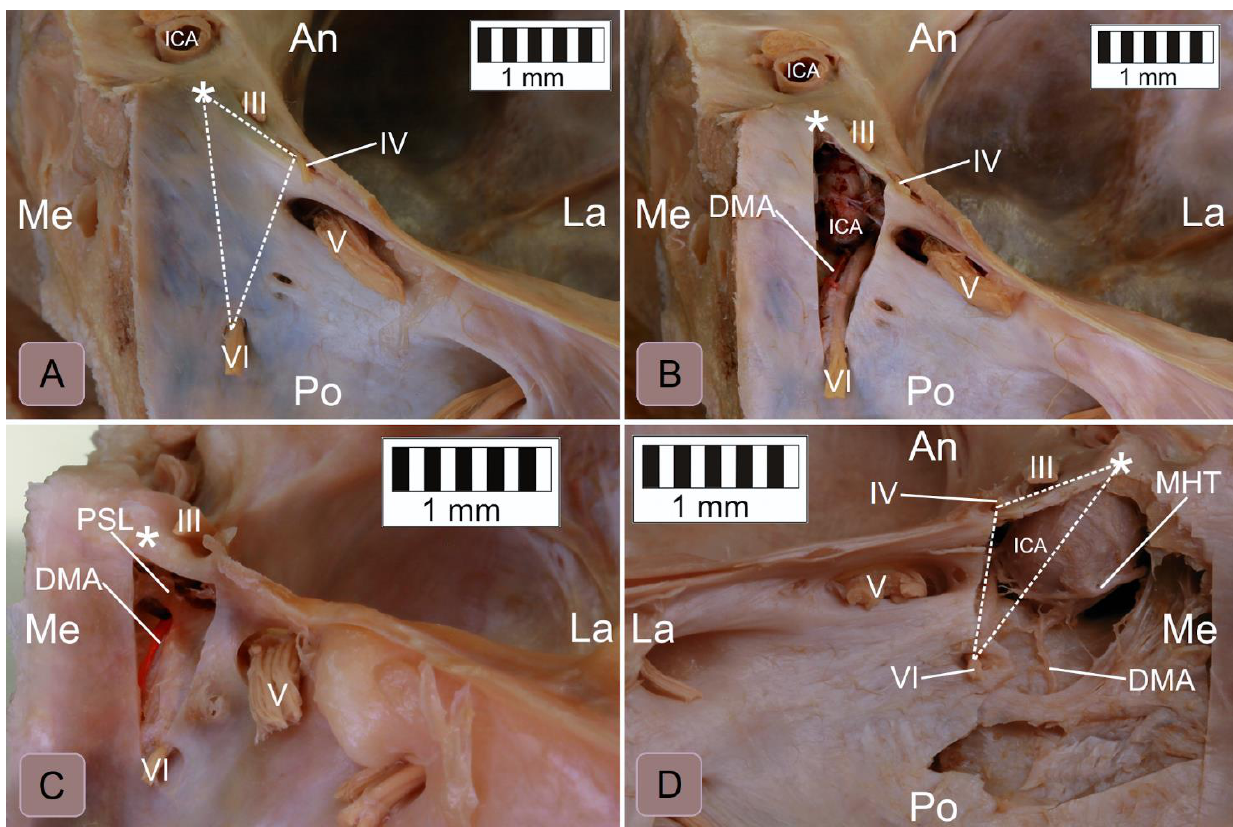
Figure 4. Anatomical variations in the inferomedial paraclival triangle’s contents. ( A ) Posterosuperior view of the right paraclival area. A dashed line marks the inferomedial triangle. ( B ) The same specimen after excision of the dura along the triangle’s borders. The petrosphenoidal ligament is absent. ( C ) Posterosuperior view of the right paraclival area, showing the specimen with the dura excised along the inferomedial triangle’s borders. A well-developed petrosphenoidal ligament (PSL) is exposed. The dorsal meningeal artery (DMA) runs under the ligament within the triangle’s medial half. The ab- ducens nerve (VI), covered by a protective dural sleeve, also runs under the ligament within the triangle’s lateral half. ( D ) Posterosuperior view of the left paraclival area. In this variant, the dorsal meningeal artery travels out of the inferomedial triangle (a dashed line marks the triangle). Note that the posterior genu of the intracavernous carotid artery occupies the upper half of the triangle. The abducens nerve courses along the lateral triangle’s border. In this specimen, the meningo- hypophyseal trunk (MHT) is located medially to the triangle. III = oculomotor nerve; IV = the dural entrance of the troch- lear nerve; V = trigeminal nerve; white asterisk = posterior clinoid process, An = anterior; Po = posterior; Me = medial; and La = lateral.